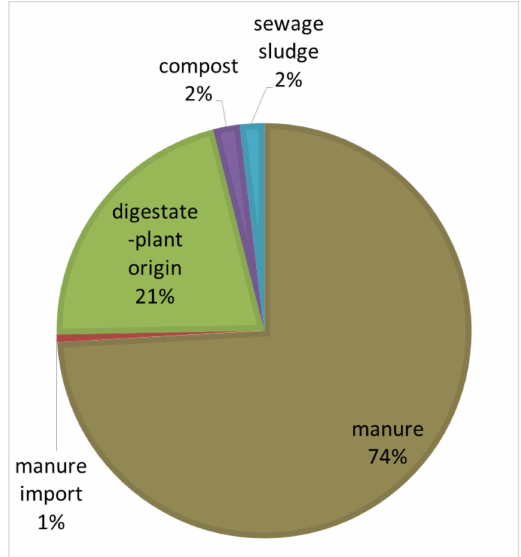
Figure 3. Nitrogen from organic fertilizers in Germany applied to soil in 2018 (source: own